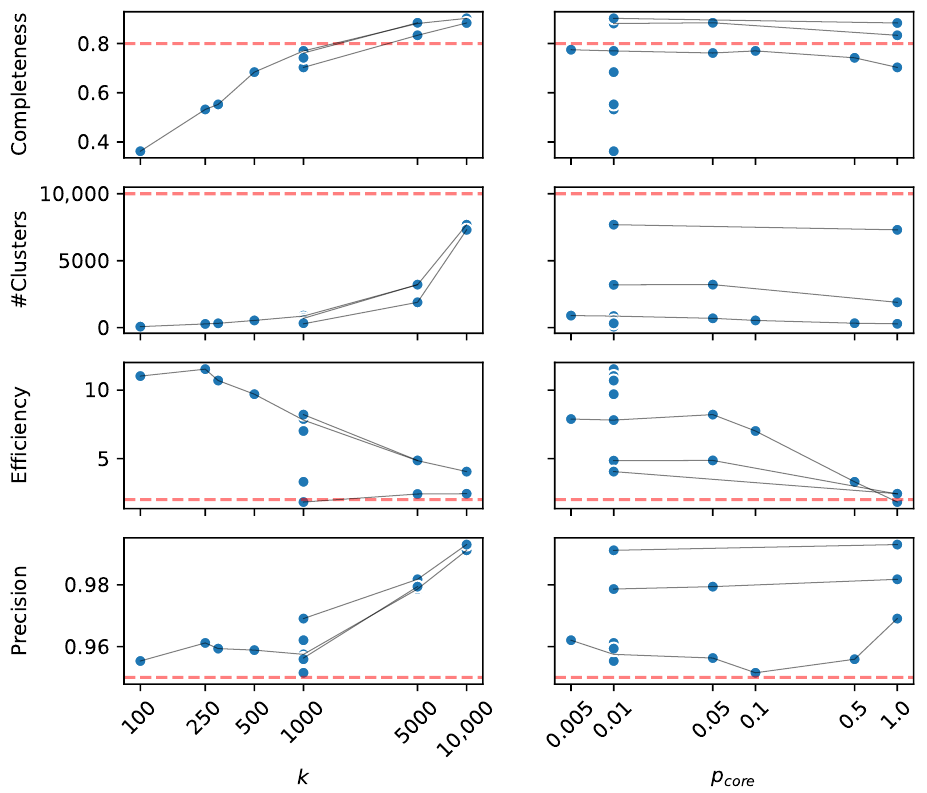
Figure A8. Shrunken k -means: Dependency of completeness, number of resulting clusters, effi- ciency and sorting precision on number of clusters k and core fraction p core . k and p core are on a logarithmic